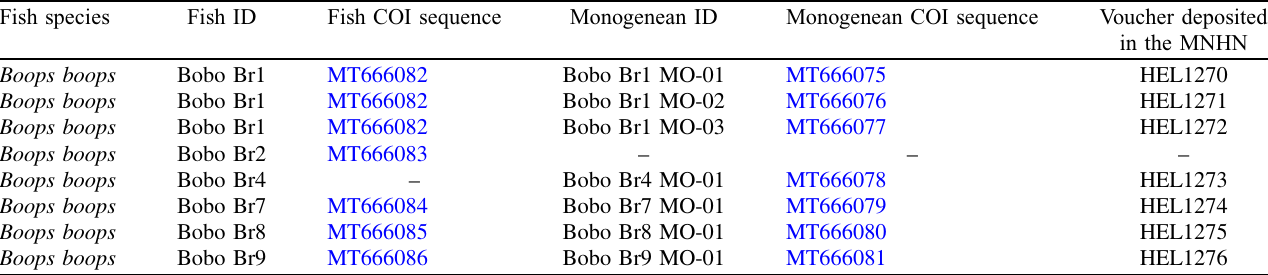
Table 1. Fish, monogeneans and their COI sequences. To insure full traceability and ensure accurate host-parasite relationships, one or several monogeneans were collected from one fi sh and all individuals were sequenced. All monogeneans in this Table were identi fi ed as Pseudaxine trachuri